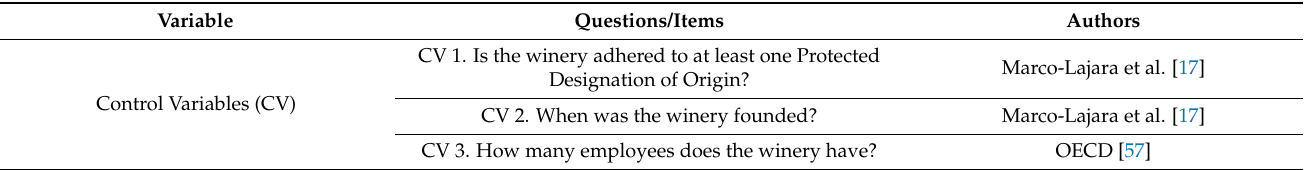
Table A1. Measures of the variables used in the